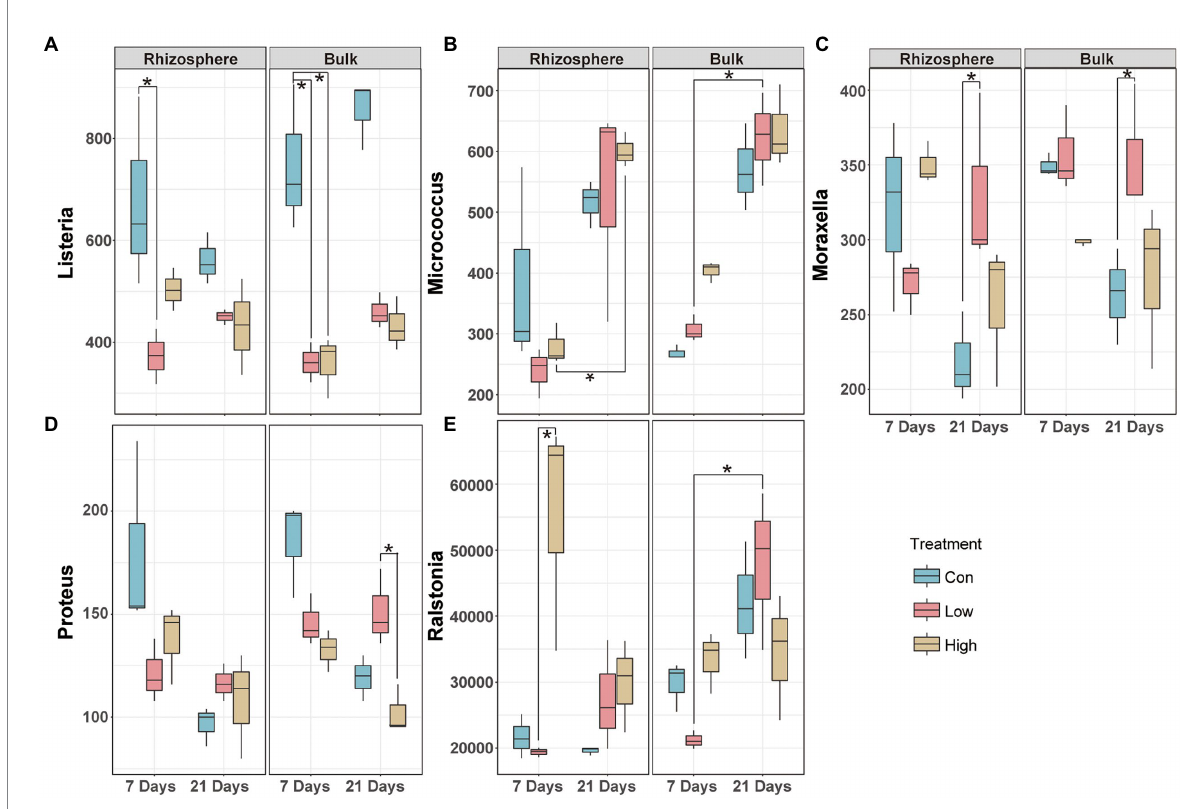
FIGURE 3 Effects of abamectin on composition of opportunistic human pathogens. Relative abundance of pathogens with or without abamectin treatments at 7 and 21 days. A-E: The five pathogens are marked in all samples. The significant difference evaluated by Kruskal–Wallis’s test (*represent p <